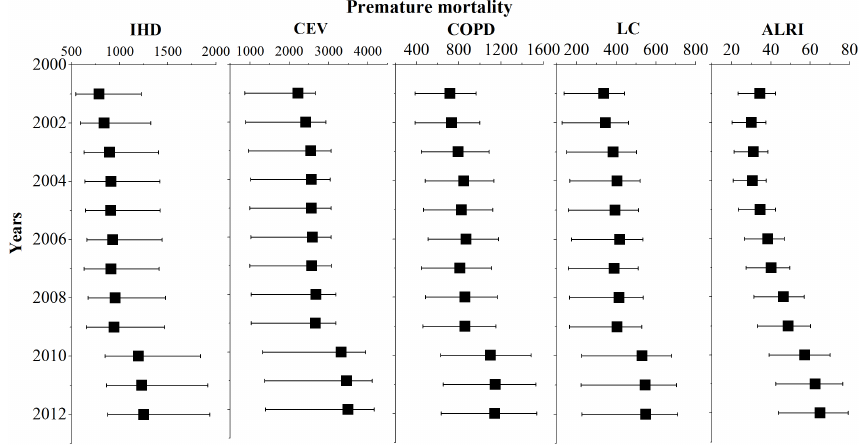
Figure 8. Yearly premature mortality attributable to IHD, CEV, COPD, and LC for people > 30years and ALRI for infants < 5years in the Beijing central area, as well as the corresponding uncertainties of the mortality estimation.